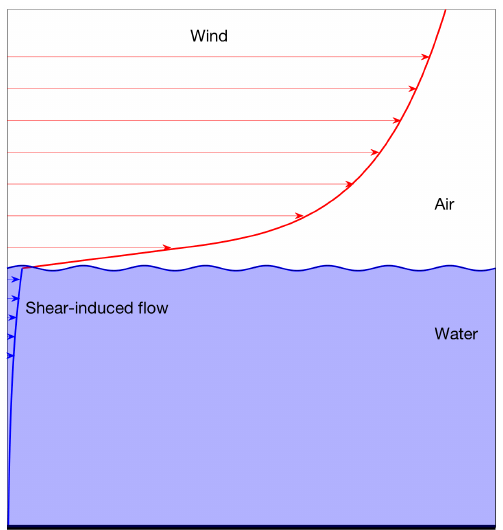
Figure 1. A Coupled shear flow. The wind blows up. Viscous effects induce a shear velocity profile in the water. Two boundary layers with high shear develop near the air-water interface. Consequently, the air-water interface is unstable and there is a growth of small water